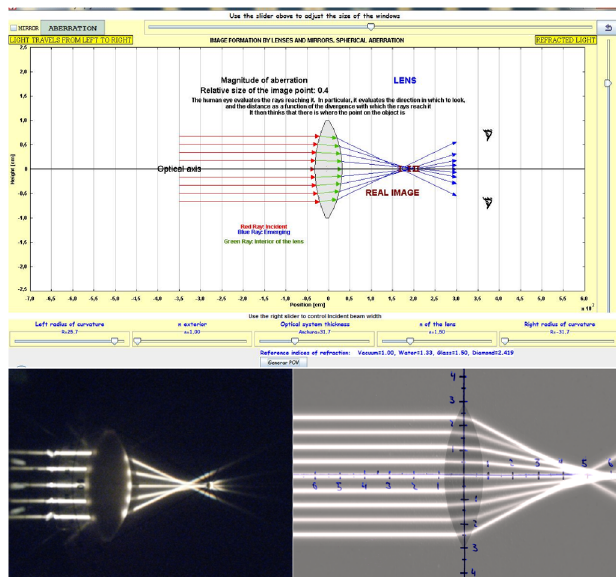
FIG. 6 (color online). Top: Virtual laboratory: View generated by the JAVA simulation of spherical aberration in a section of a biconvex lens. Bottom left: Photograph of a section of a bicon- vex lens working outside the paraxial zone. Bottom right: Hyper- realistic simulation of the same optical